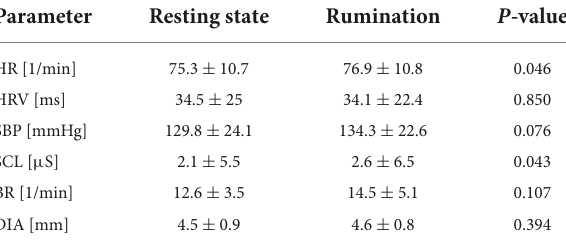
TABLE 2 Changes in autonomic function during rumination compared to rest.